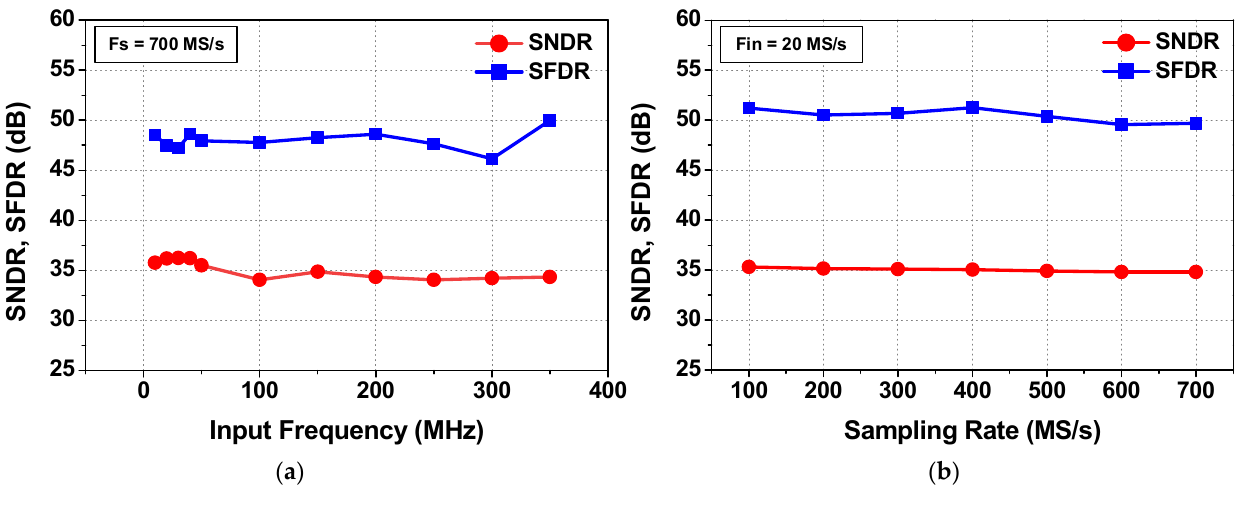
Figure 14. Measured SNDR and SFDR with various ( a ) input frequencies at 700 MS/s, ( b ) sampling rates with a 20 MHz input.